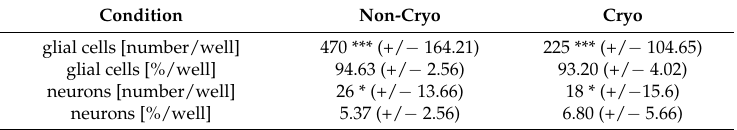
Values represent mean +/ − SD; n = 24 wells (8 different dogs, 3 wells per dog and condition); Non cryo = non-cryopreserved, cryo = cryopreserved, DiV = days in vitro, SD = standard deviation. * = p < 0.05, *** = p < 0.001. Employed statistical test: Mann-Whitney